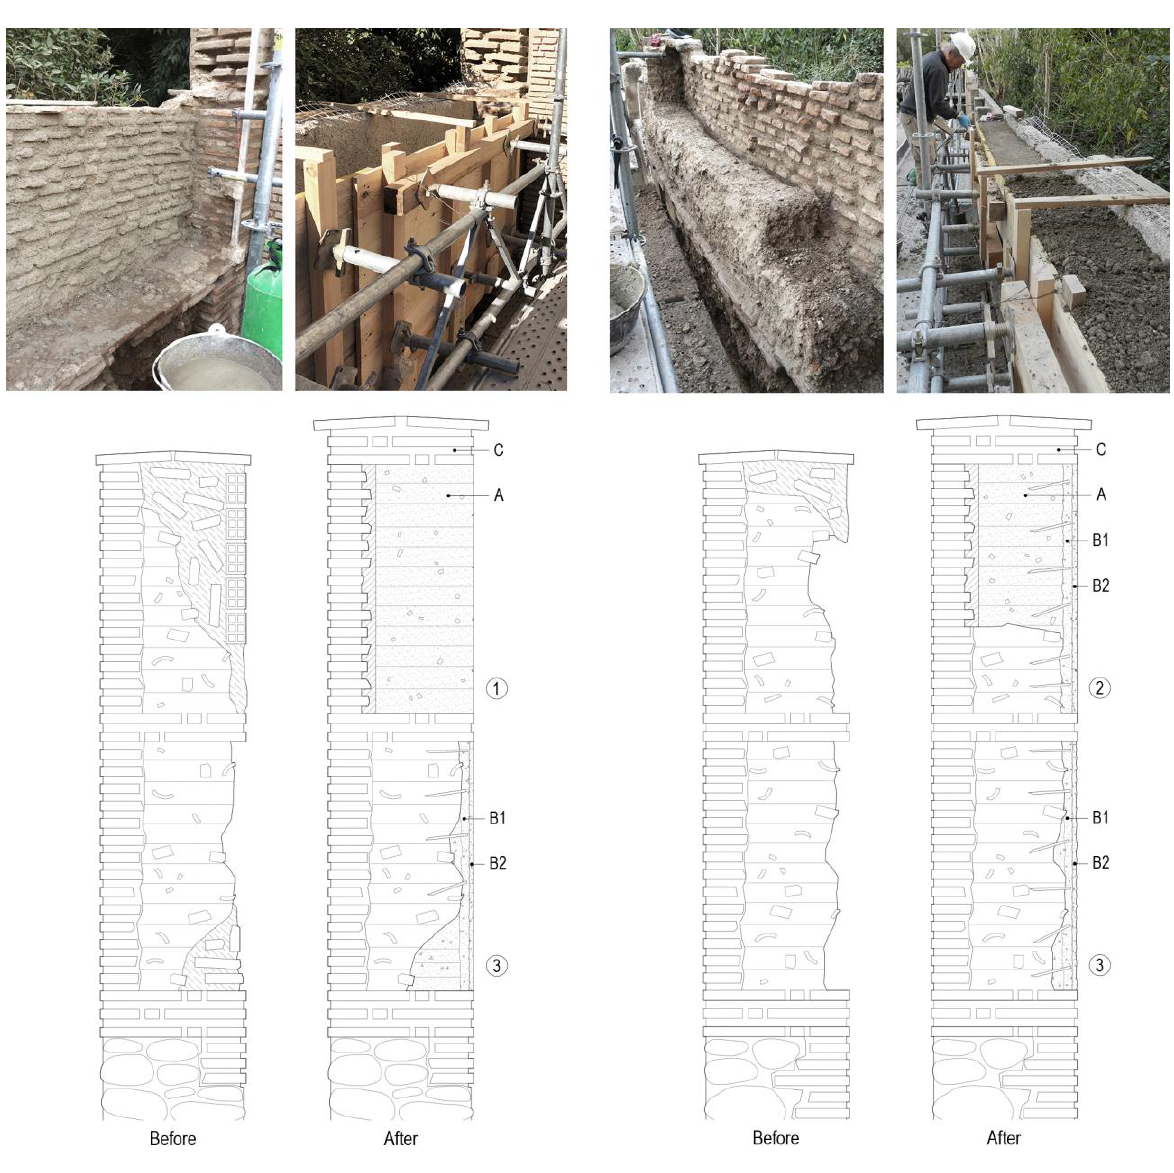
Figure 6. Left: Section pl. 1 / Right: Section pl.